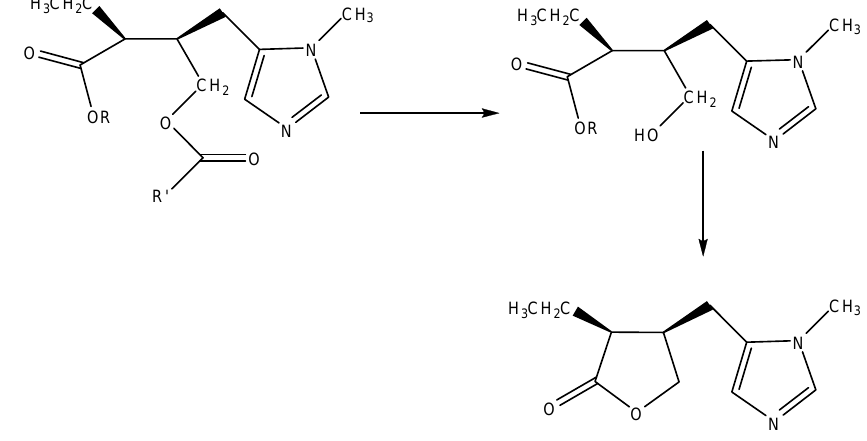
Figure 1. Pilocarpic acid diesters prodrugs and their hydrolysis in the ocular tissue.